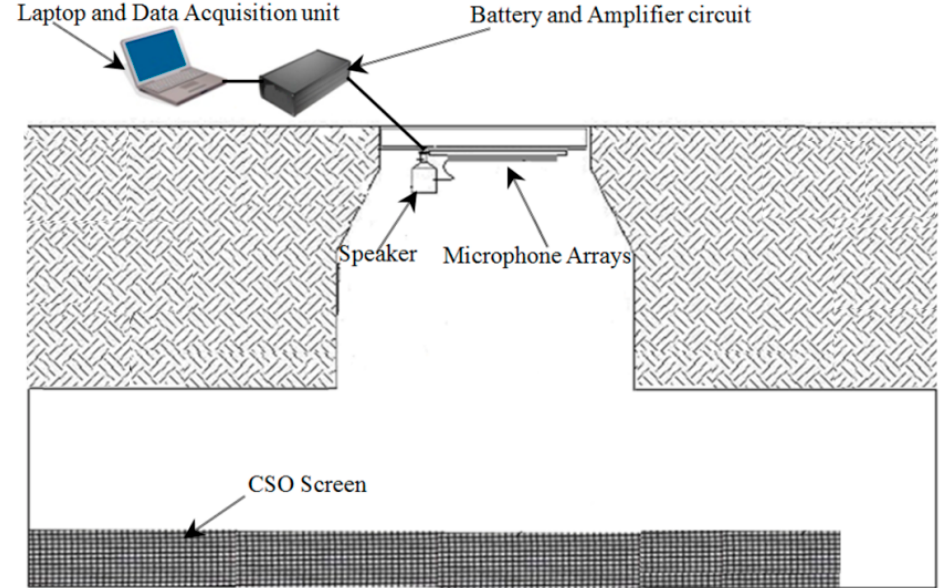
Figure 4. Installation diagram of the acoustic sensor in the chamber. The first field trial site was located under a public highway located in West